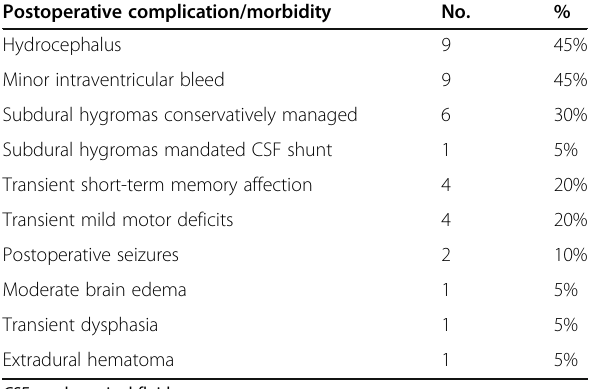
Table 5 Postoperative complications and